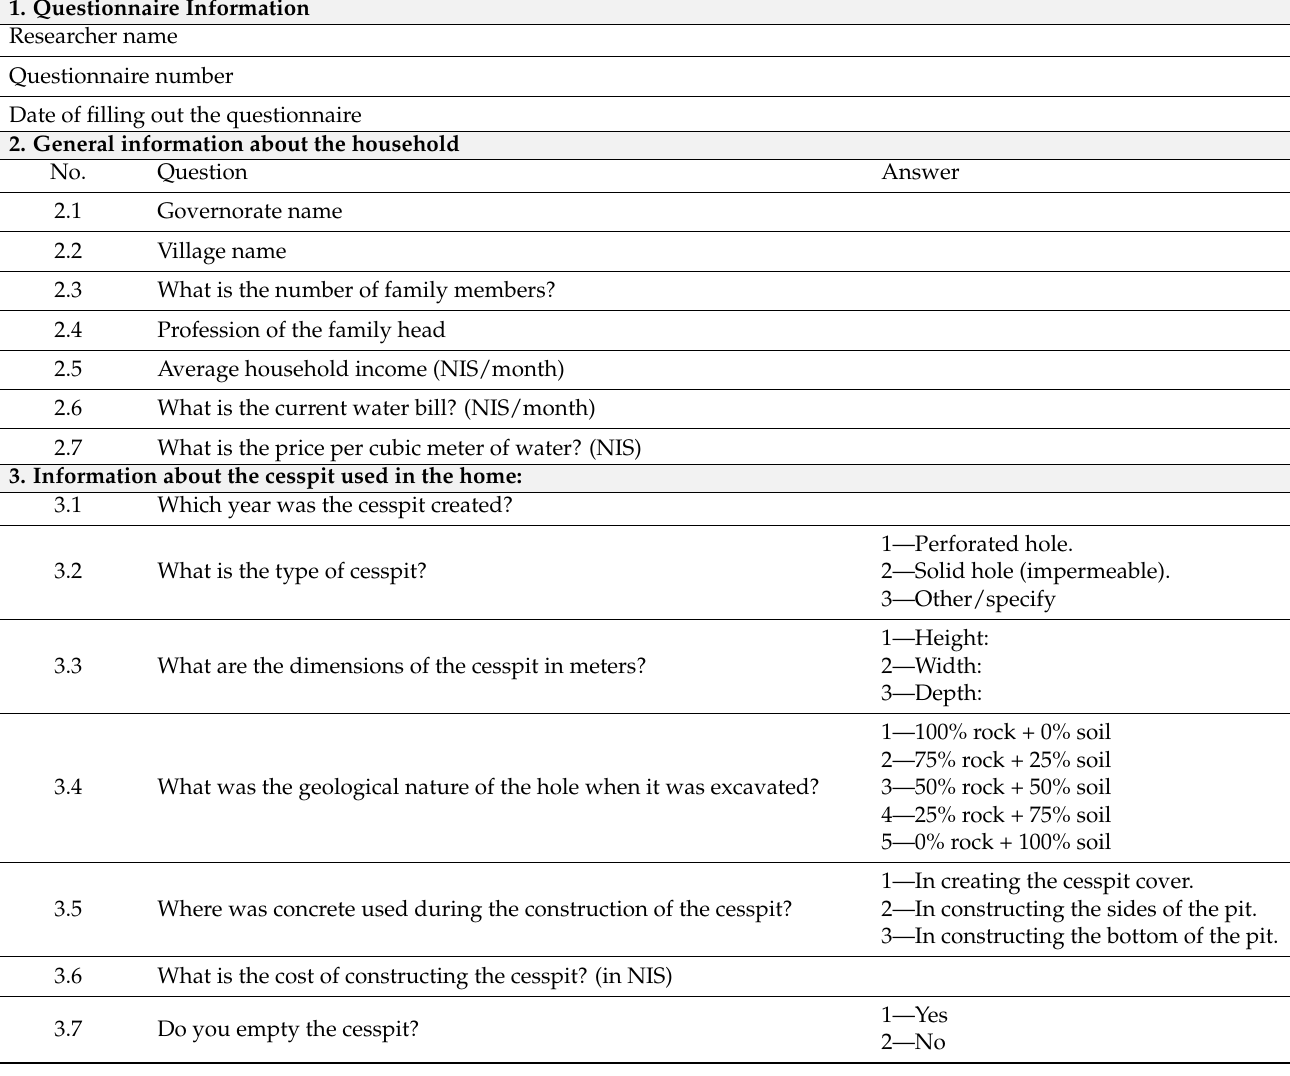
Table A1. Cesspits Survey